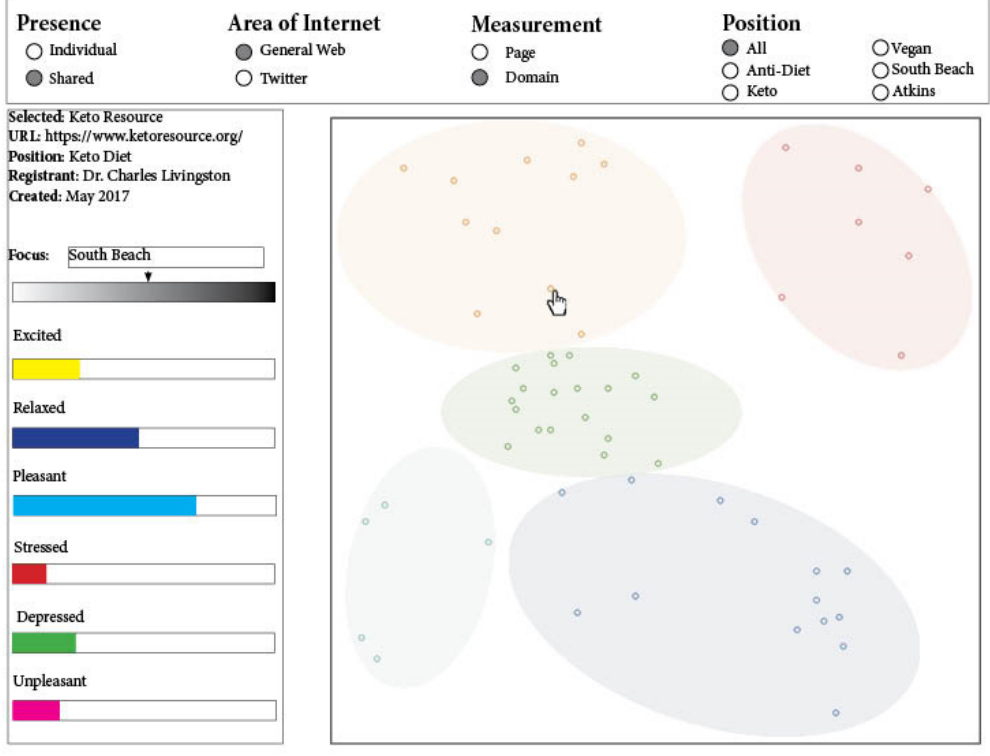
Figure 13. VAS for